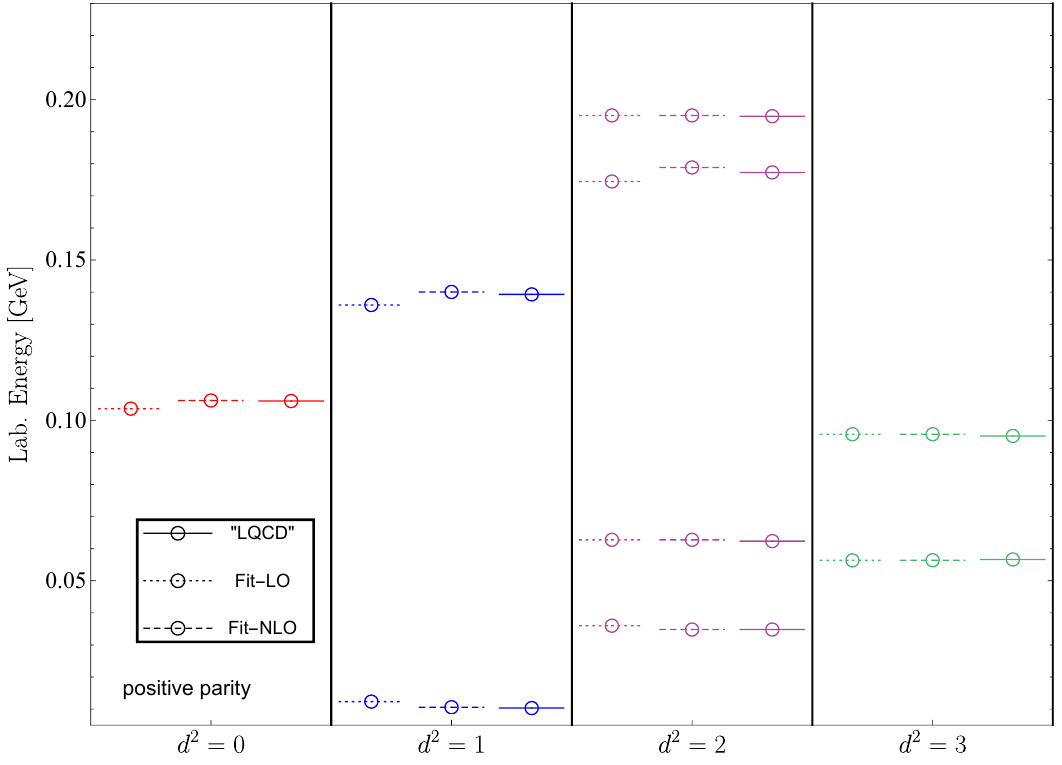
Figure 8 . Comparisons of the synthetic lattice energy levels with positive parity in the box with L = 5 fm and those from the EFT determined by fitting. The marker shapes represent the irreps, which are the same as those in figure